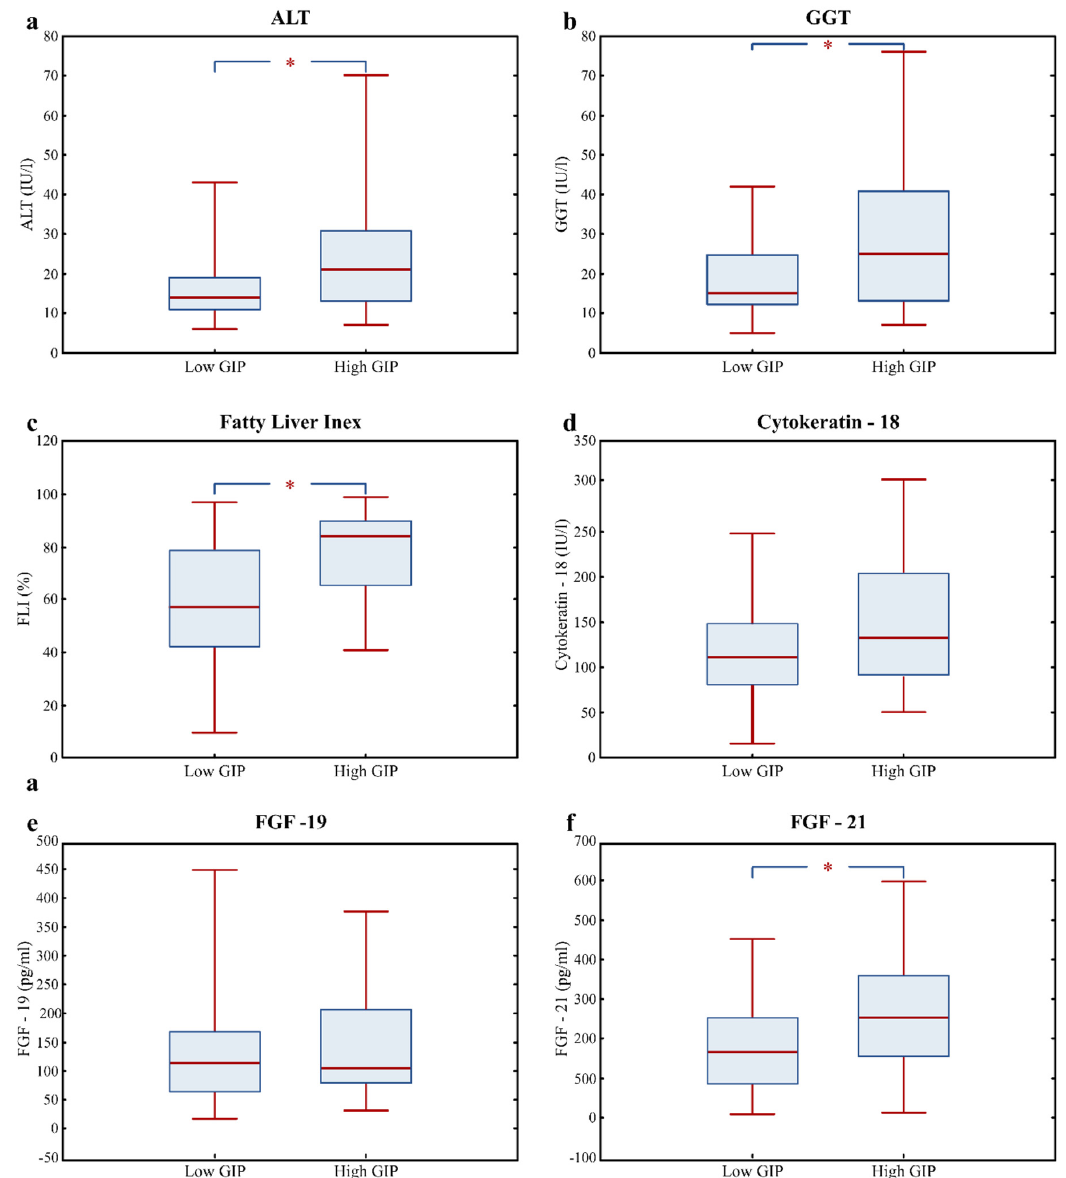
Figure 1. Fatty liver risk markers: ALT ( a ), GGT ( b ), FLI ( c ), cytokeratin-18 ( d ), FGF-19 ( e ), and FGF-21 ( f ) in the Low GIP ( n = 85) and High GIP ( n = 43) groups of patients. Values are presented as median (line), upper and lower quartile (box), and minimum and maximum (whiskers). Significant differences are indicated as * p < 0.05 (Mann–Whitney U test, Statistica softaware v.13). Abbreviations: High GIP—group of subjects with fasting plasma GIP level >66th percentile, Low GIP—group of subjects with plasma fasting GIP level ≤ 66th, ALT—alanine aminotransferase,